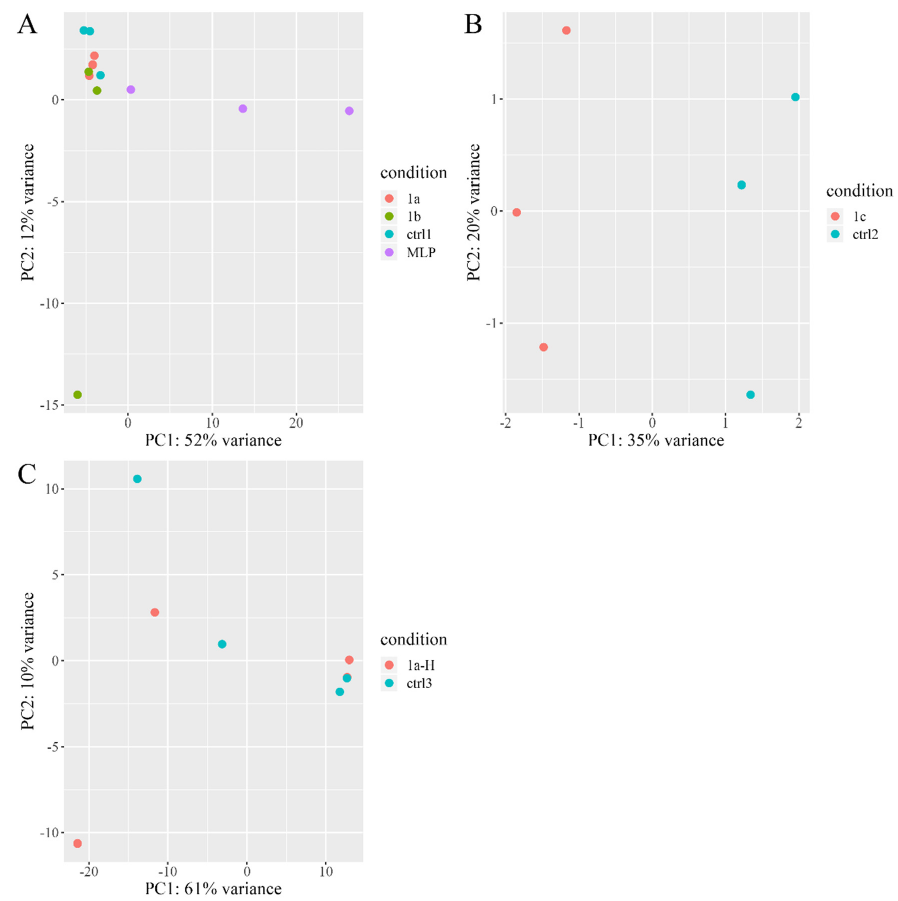
Figure 3. Scatter plot presenting the distribution of samples in the two-dimensional coordinate system determined by the first (PC1) and the second (PC2) principal components, which were